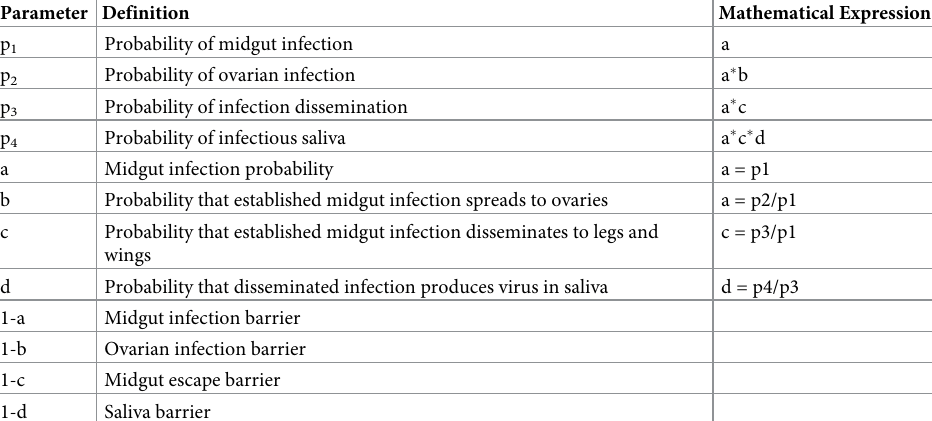
Table 1. Parameters used in within-host model. See also S1